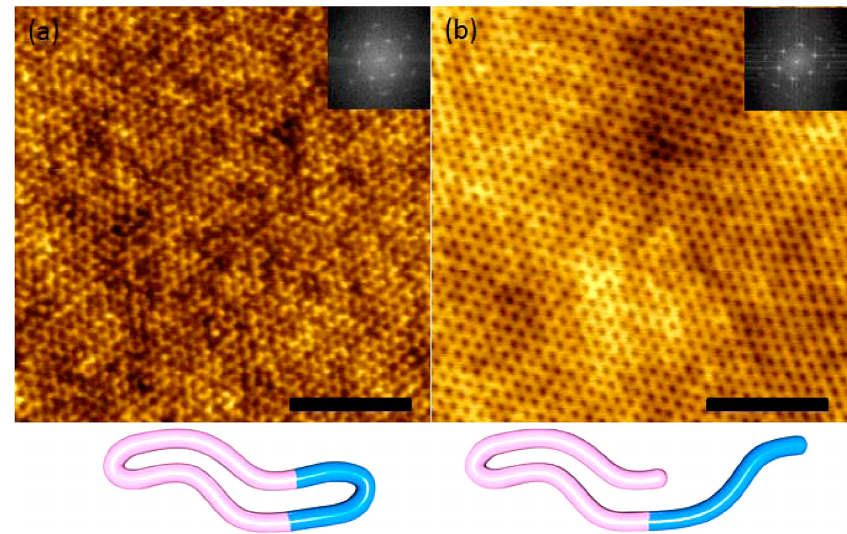
Figure 19. Atomic force microscopy height images for ( a ) cyclic PS13K- b -PEO5K and ( b ) PS13K- b -PEO5K diblock copolymers (inlet: 2D fast Fourier transform (FFT) of AFM images). Scale bars are 250 nm. Reprinted from Reference [11]. (Copyright (2012) American Chemical Society).